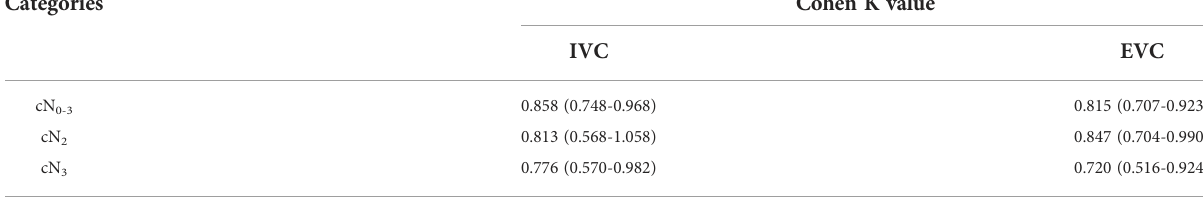
TABLE 4 Unweighted Cohen ’ s kappa tests for validating the performance of the receiver operating characteristic models. Categories